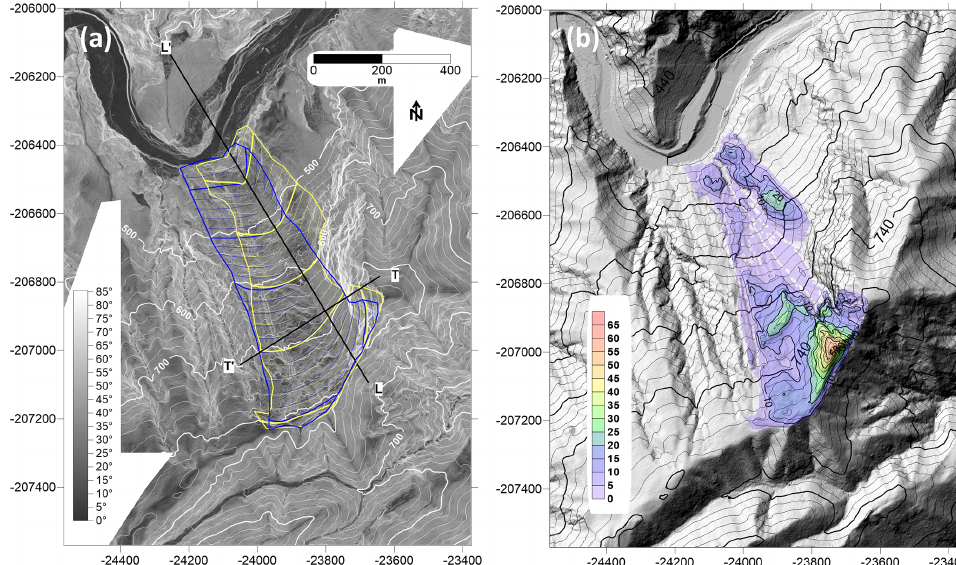
Figure 20. (a) Slope angles of the area around the Akatani-east landslide after the event (white contours). The blue contours correspond to scenario 1, and the yellow contours correspond to the mixed scenario. (b) Hillshade of the pre-DEM with contours in black, displaying the thickness of the material in metres above the mixed scenario result. The cross section is indicated.